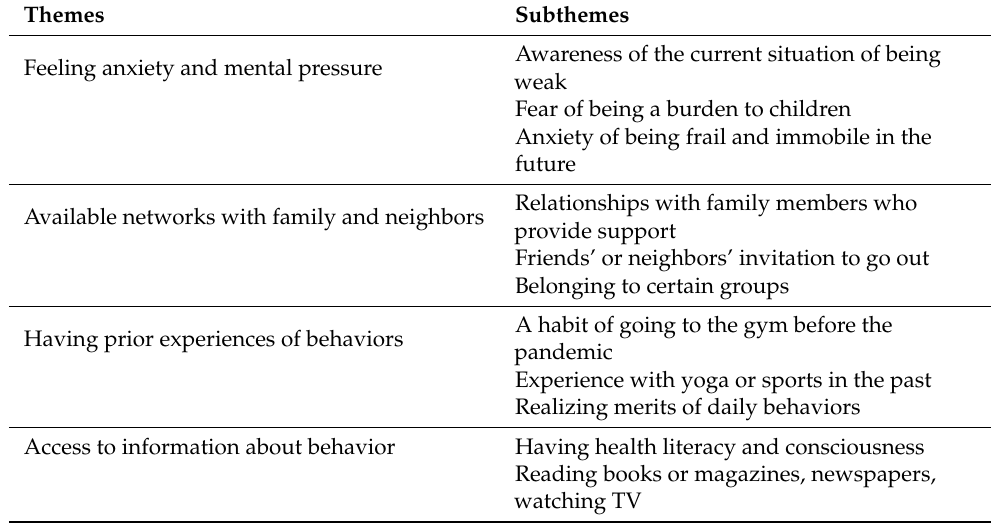
Table 3. Reasons and triggers for the preventive behaviors against declining physical fitness during the COVID-19